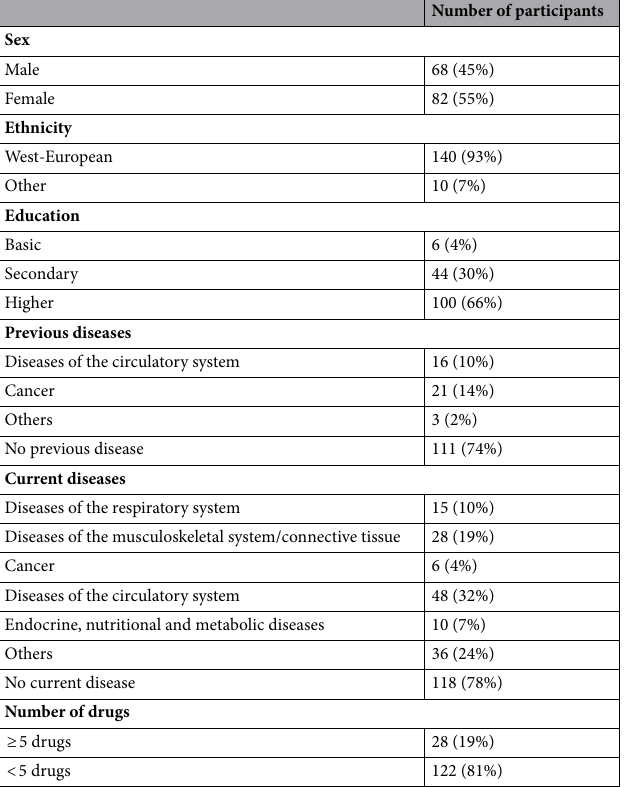
Table 1. Demographic characteristics of participants (n = 150).